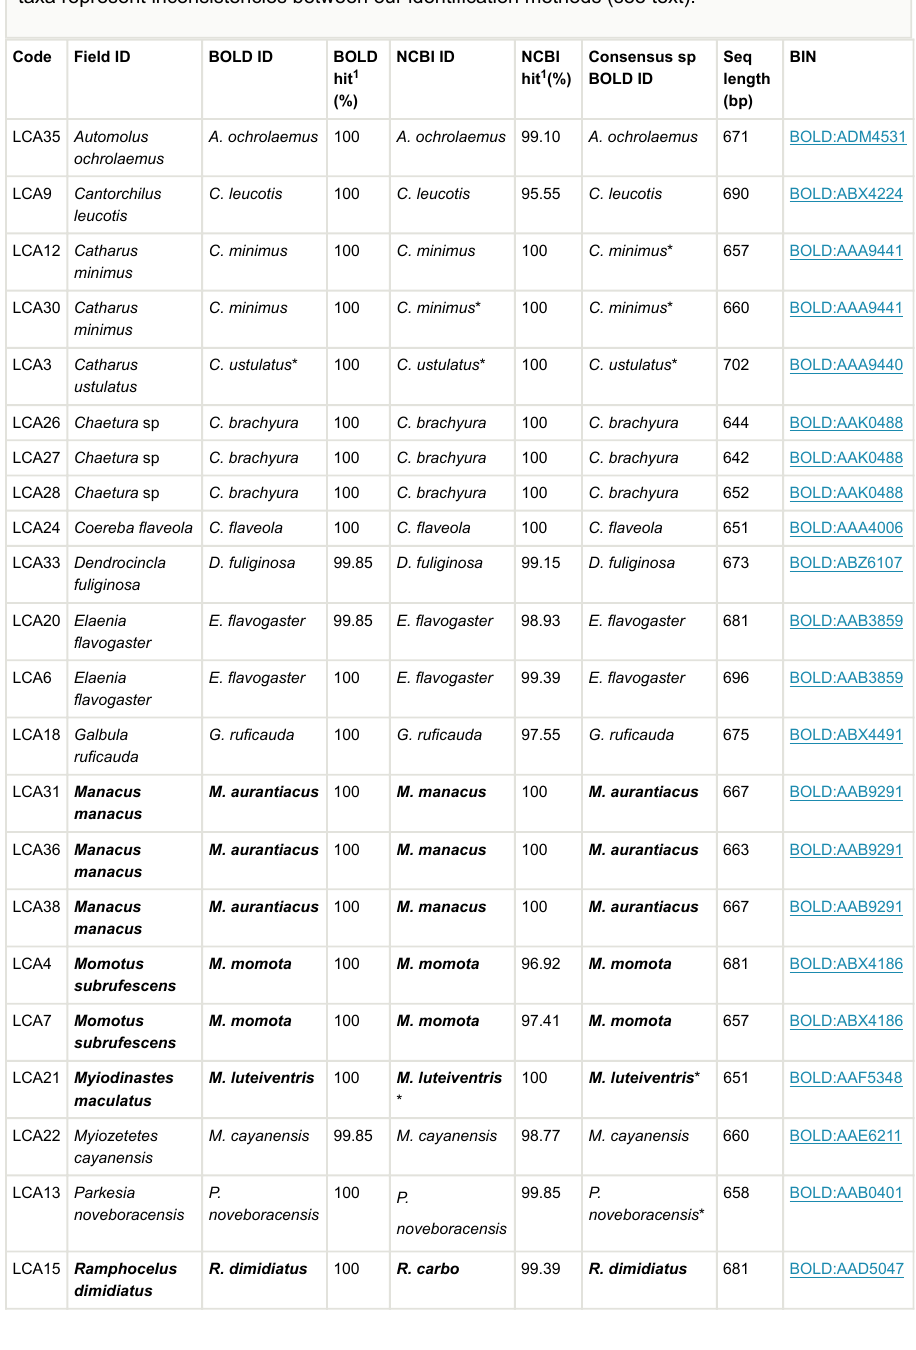
Table 2. Individuals sampled and barcoded in this study. Individuals with * represent boreal migrants. Bolded taxa represent inconsistencies between our identification methods (see